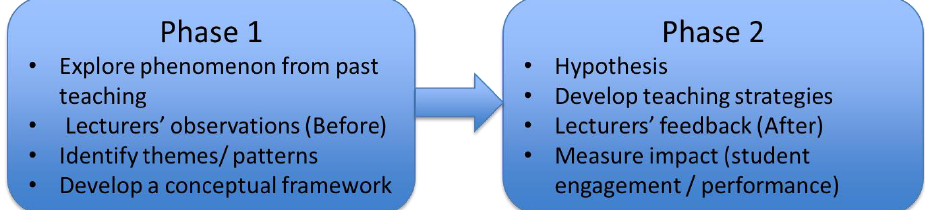
Figure 5. Two-phase iteration for implementing smart classroom teaching activities. Table 1. Sample student self-evaluation questionnaire.